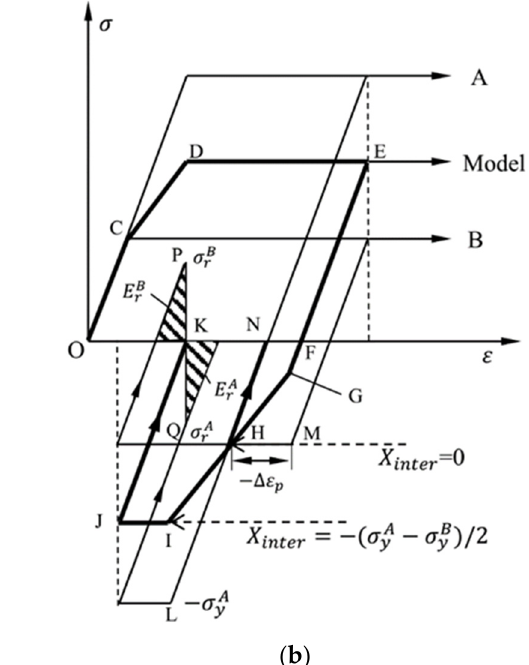
Figure 4. Stress–strain relation for the model is shown in Figure 3: ( a ) tension-going and ( b ) compression-going. The letters “A” and “B” represent two elements with different yield stresses σ A y and σ B y .